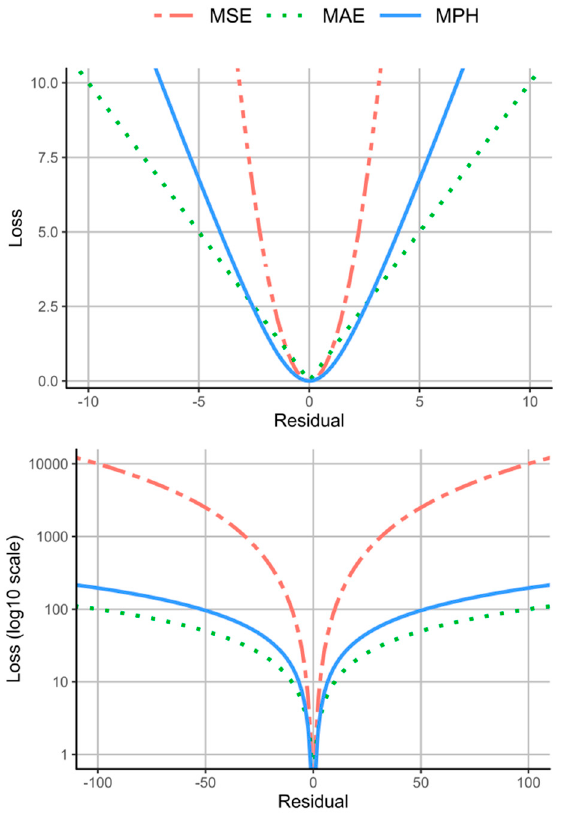
Figure 6. Comparison of the tested loss functions: mean squared error (MSE), mean absolute error (MAE), and mean pseudo-Huber (MPH) (Equation (2)) (delta = 2).